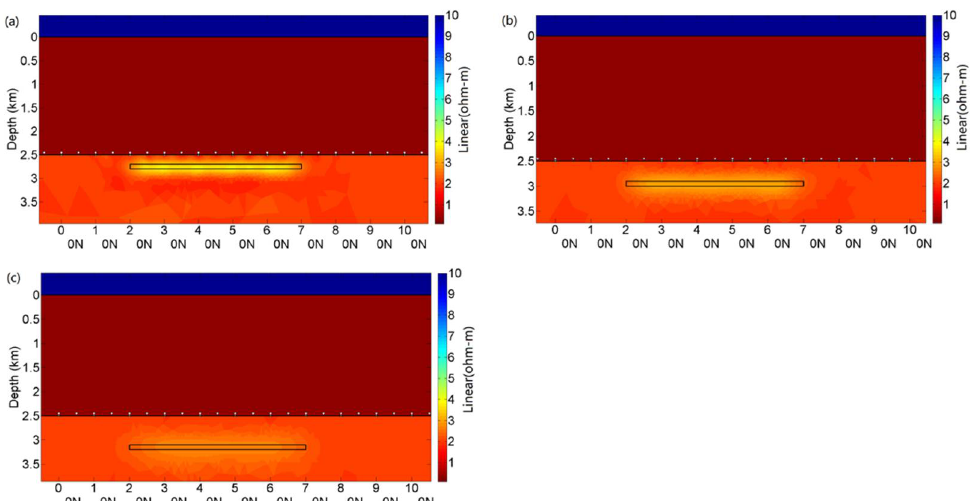
Figure 2. Inversion results of different values of the target depth. ( a ) Burial depth: 200 m; ( b ) Burial depth: 400 m; ( c ) Burial depth: 600 m.